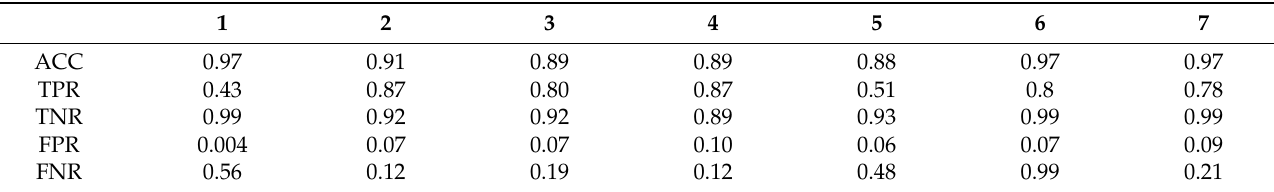
Table 3. Confusion matrix of representative